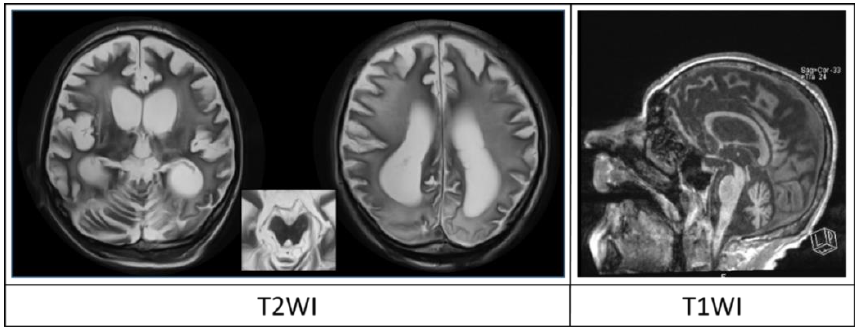
Figure 3. T2-WI and T1-WI of patient O., male, aged 56, in UWS due to an episode of anoxia 5 months prior to MRI (see patient No 26 in Table 2 for detailed information). Conventional MRI demonstrated diffuse cortical atrophy (score 1), moderate ventricular enlargement with Evans index of 0.41 (score 1) and severe sulcal widening up to 0.7 cm (score 2); severe leukoaraiosis with confluent diffuse periventricular areas of changed intensity spreading to the deep white matter and up to the very cortex (score 2), moderate corpus callosum degeneration with the thickness of its central part at 0.3 cm (score 1) and brainstem and thalamus degeneration (score 1). The total DOC-MRIDS score is 8, which corresponds to UWS (CRS-R-6, also corresponding to UWS).